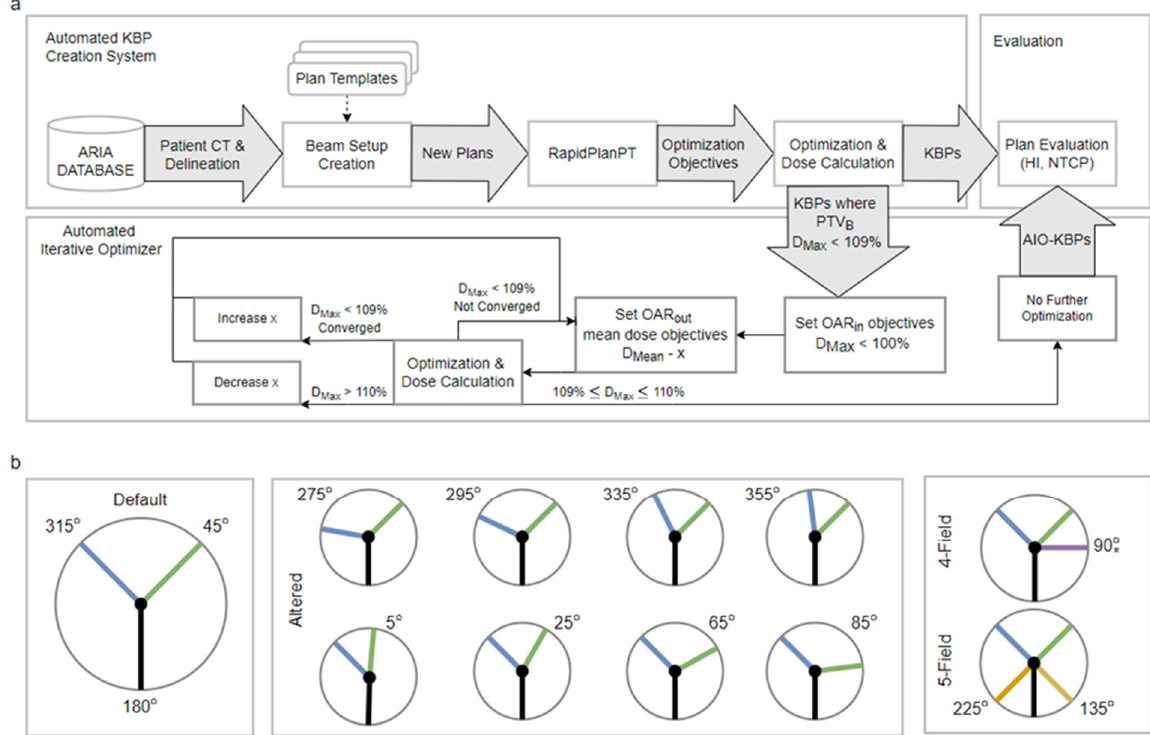
Figure 1. ( a ) KBP-creation and AIO-processing workflow. ( b ) Illustration of beam angle arrangements. The angles not separately indicated in the middle- or right-pane diagrams are the same as in default arrangement. * In the 4-field arrangement the additional field is added ipsilaterally of the PTV, i.e., either to 90 or 270 degrees. KBP = knowledge-based plan; AIO = automatic iterative optimizer; HI = homogeneity index; NTCP = normal tissue complication probability; OAR = organ at risk.